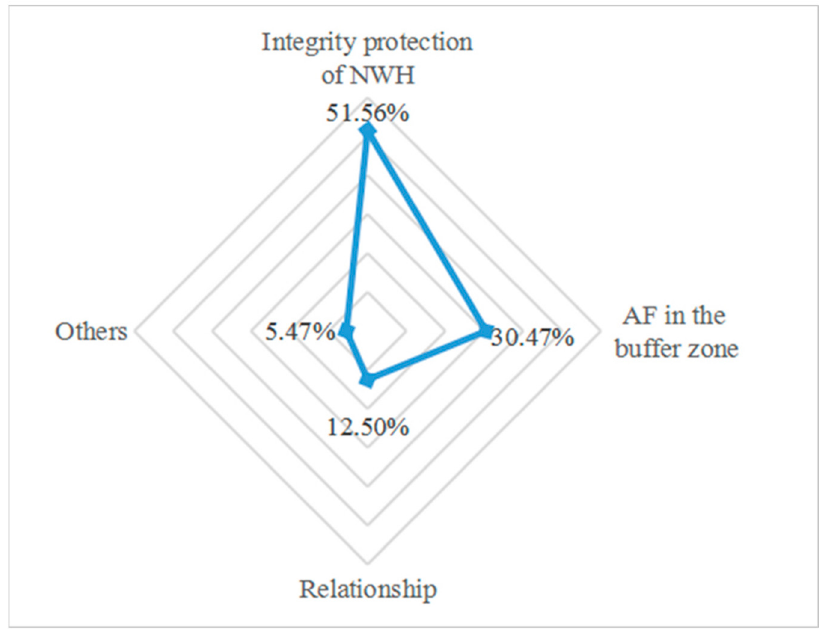
Figure 5. Distribution of research contents.